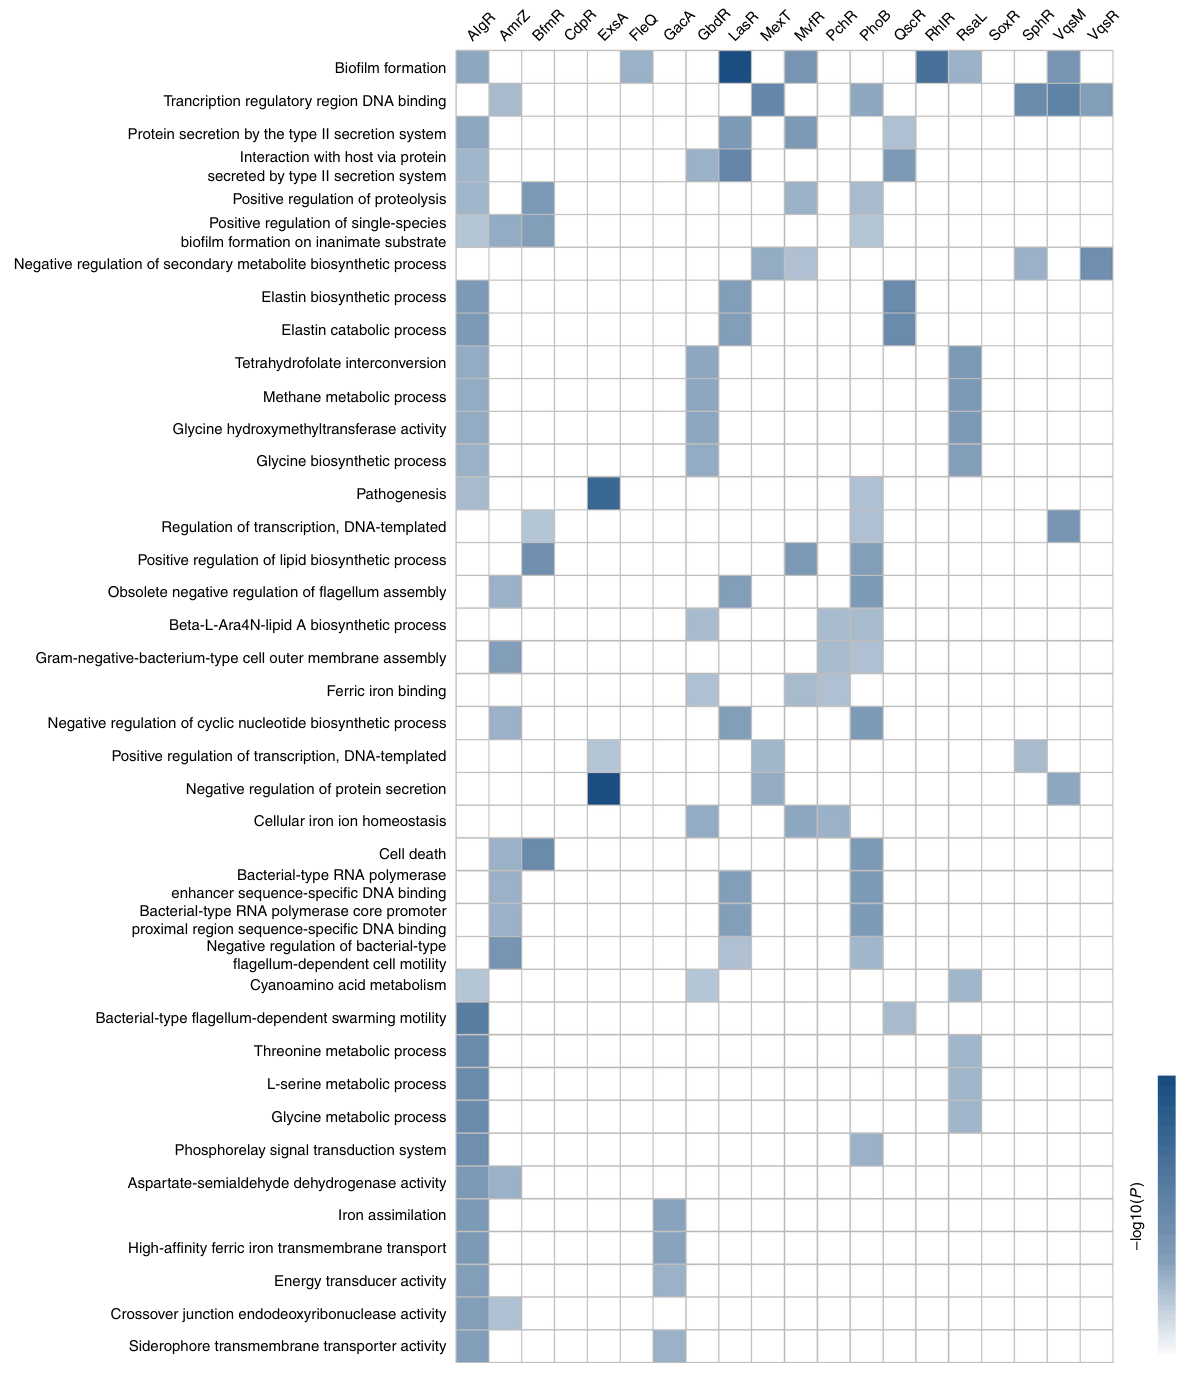
Fig. 5 Functional characterization of the PAGnet. The PseudoCAP annotation was used to categorize the targets of 20 transcription factors in network. The colour shade of different block indicates the signi fi cance of each TF on every functional category (-log10 ( P